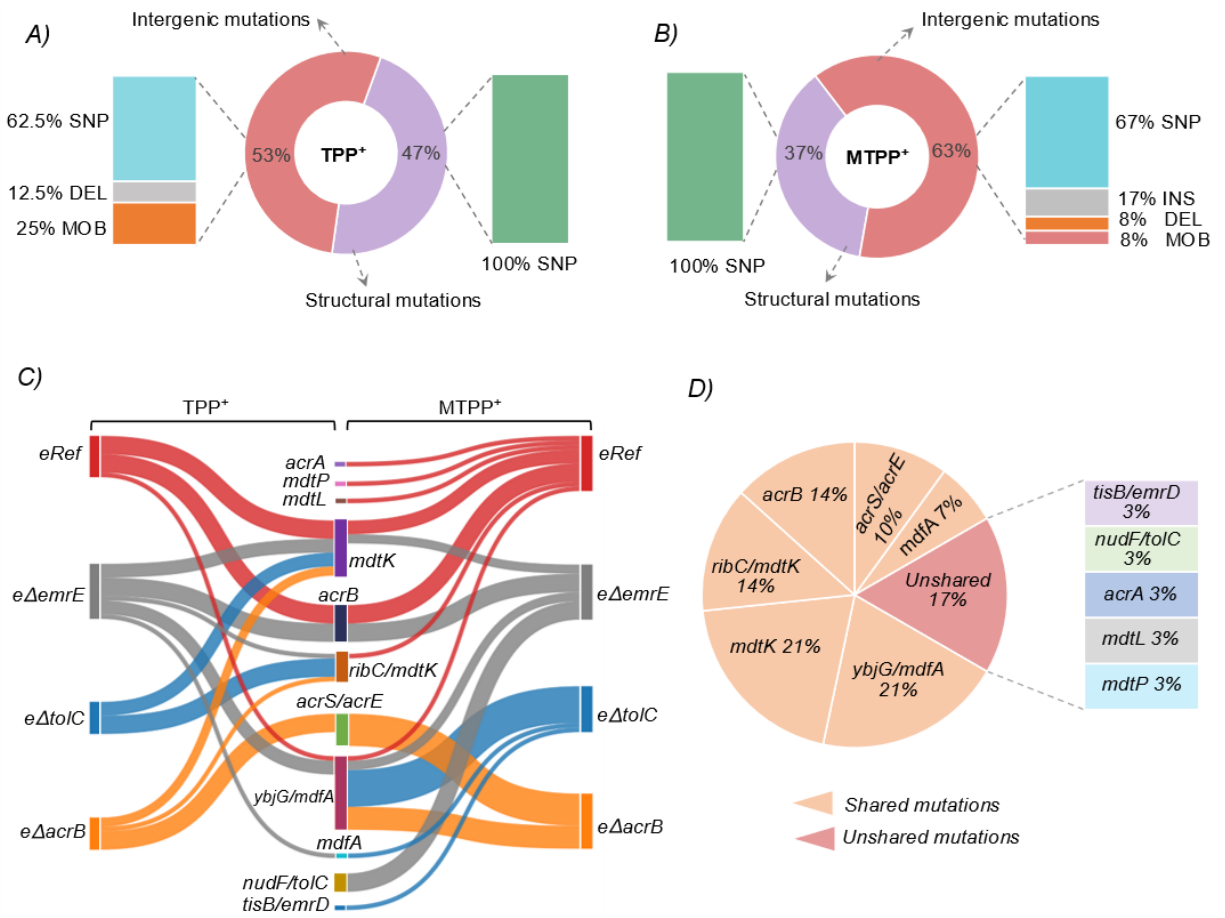
Figure 4. Overview of identified mutations affecting MDTs. ( A ) Info chart of mutations targeted MDTs in TPP + evolution experiments. Mutations split into 47% of structural (coding) mutations and 53% of intergenic (non-coding) mutations. All structural mutations were SNPs, while intergenic mutations categorized as 63% SNPs, 13% DELs, and 25% MOB. ( B ) Info chart of mutations targeted MDTs in MTPP + evolution experiments. Intergenic mutations represented 63%, and varied between SNPs (67%), INSs (17%), DELs (8%), and MOB (8%). The remaining share (37%) represented the structural mutations, and all were SNPs. ( C ) A Sankey diagram linking the mutations occurred in all strains tested in TPP + and MTPP + . Line width represent the number of unique occurrences in which a given ORF or ORF intergenic region was mutated. Genes or genetic region that lack a dual link between the two conditions are unshared. ( D ) Info chart illustrating the mutated ORF or ORF intergenic regions that are shared between the strains tested in both conditions (orange pies), and the unshared mutations (red pie), and the bars enumerate the unshared genes/genes intergenic regions. Percentages are rounded to the whole number. (Abbreviations: SNP: single-base substitution, MOB: mobile element insertion, DLE: deletion, and INS: insertion).